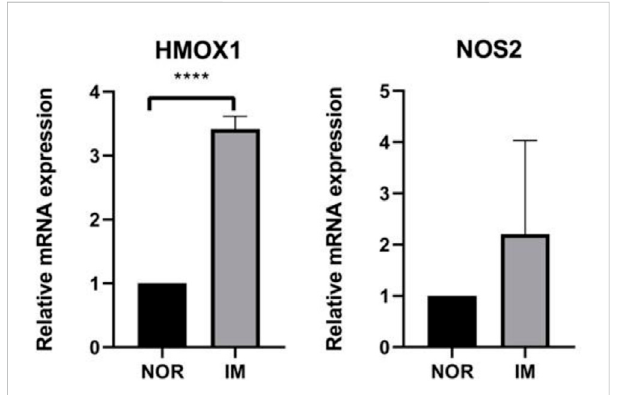
FIGURE 7 The expression levels of the three FRGs between healthy control group ( n = 5) and IM group ( n = 5). **** p <